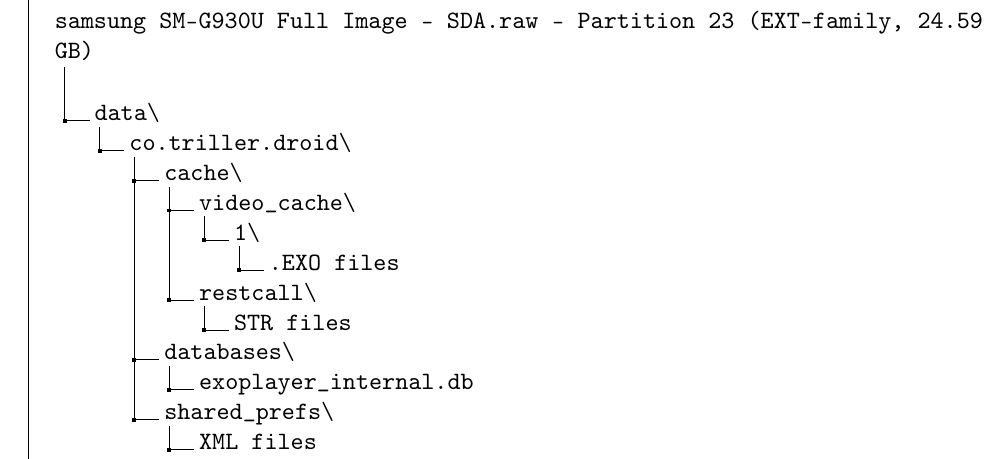
Figure 20. Triller Android file structure as captured in Magnet AXIOM